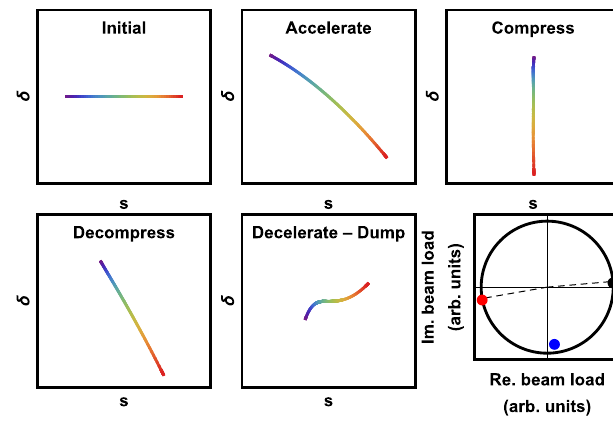
FIG. 4. Example IA: Compressive match with SR loss com- pensation. Image sequence as per Fig. 3. Choosing decom- pressing R 56 of equal and opposite sign to compressing now results in finite residual chirp as we must move decelerating phase further off-trough to account for SR energy loss. rf phase choices during acceleration (black), deceleration (red), and x 10 resulting beam load (blue) for